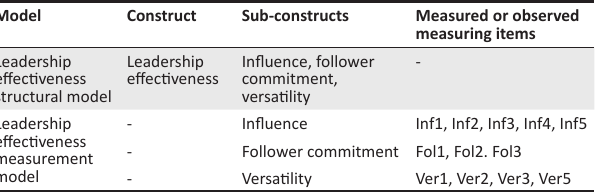
TABLE 5: Definition of structural constructs and measurements for the leadership effectiveness model and its sub-constructs.